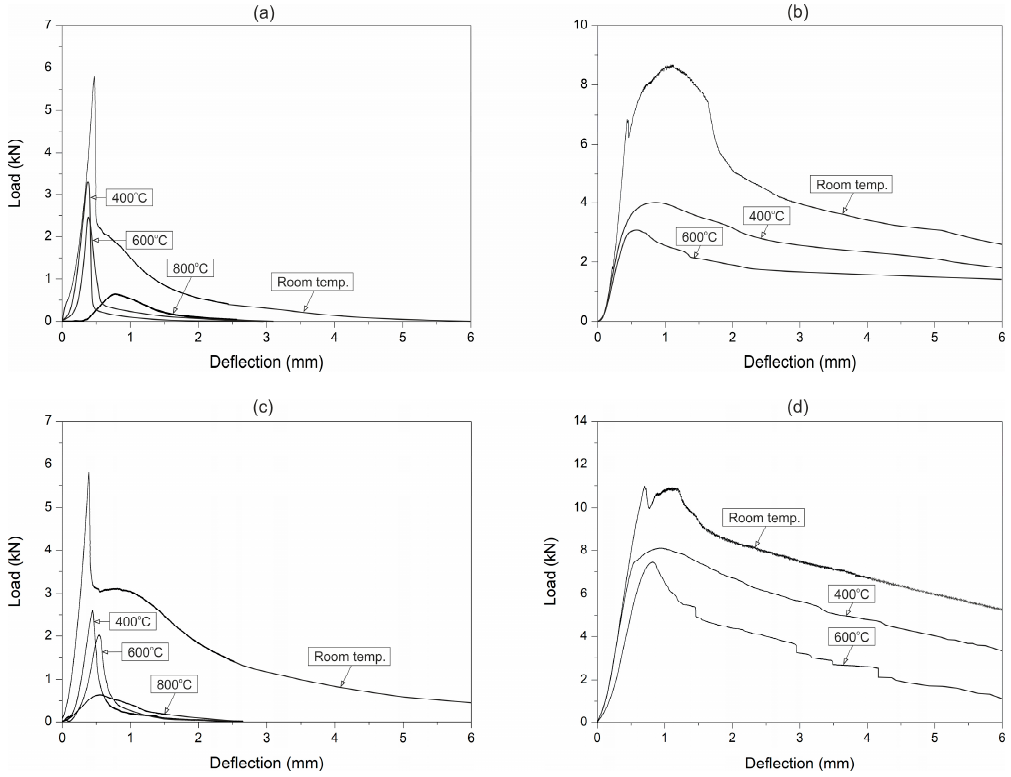
Figure 6. Flexural responses of ( a ) CPP-1, ( b ) CS-1, ( c ) CPP-2, and ( d ) CS-2 concretes at high